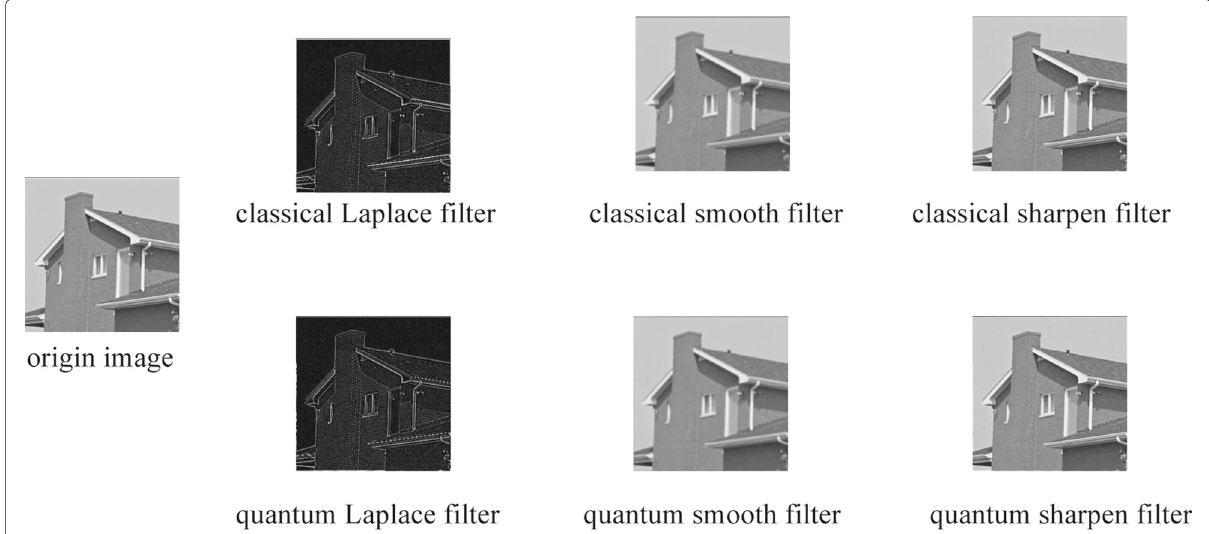
Fig. 3 Three types of image processing, edge detection, image smoothing, and sharpening, are implemented on an image by classical method and quantum method